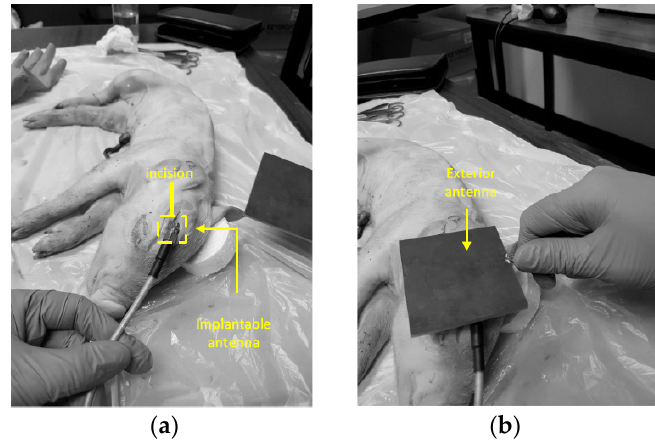
Figure 9. Measurement of the proposed NRIC WPT link for a piglet [106]. ( a ) An incision was created in the skull to embed RX coil over the brain. ( b ) Position of the external TX coil. Copyright © 2018, IEEE.